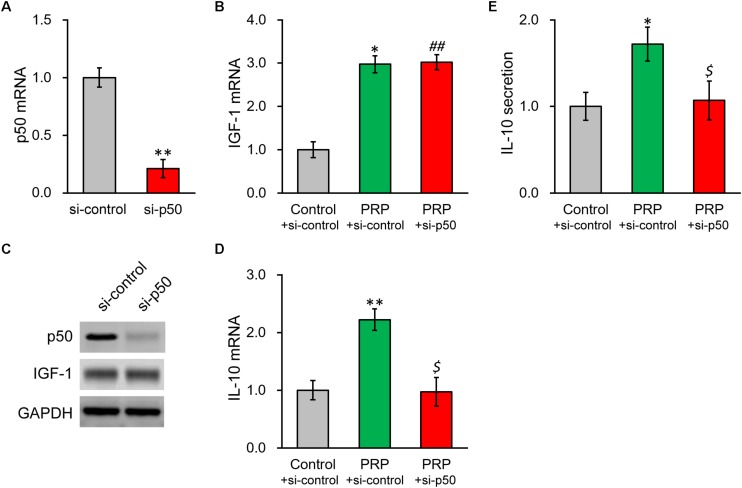
Knockdown of NF-κB p50 subunit abolishes PRP-induced expression and secretion of IL-10 in BMSCs. (A) p50 mRNA, (B) IGF-1 mRNA, and (C) their protein levels were examined in control knockdown BMSCs (si-control) and p50 knockdown BMSCs (si-p50). (D) IL-10 mRNA levels were examined in control knockdown BMSCs (si-control), control knockdown BMSCs treated with PRP (PRP + si-control), and p50 knockdown BMSCs treated with PRP (PRP + si-p50). (E) IL-10 levels in media culturing control knockdown BMSCs (si-control), control knockdown BMSCs treated with PRP (PRP + si-control), and p50 knockdown BMSCs treated with PRP (PRP + si-p50). Values are mean ± SD at least three independent biological repeats in triplicates. ∗∗P < 0.01, ∗P < 0.05, vs. si-control. ##P < 0.05 vs. si-control and not significant vs. PRP + si-control. $ not significant vs. si-control and P < 0.05 vs. PRP + si-control.